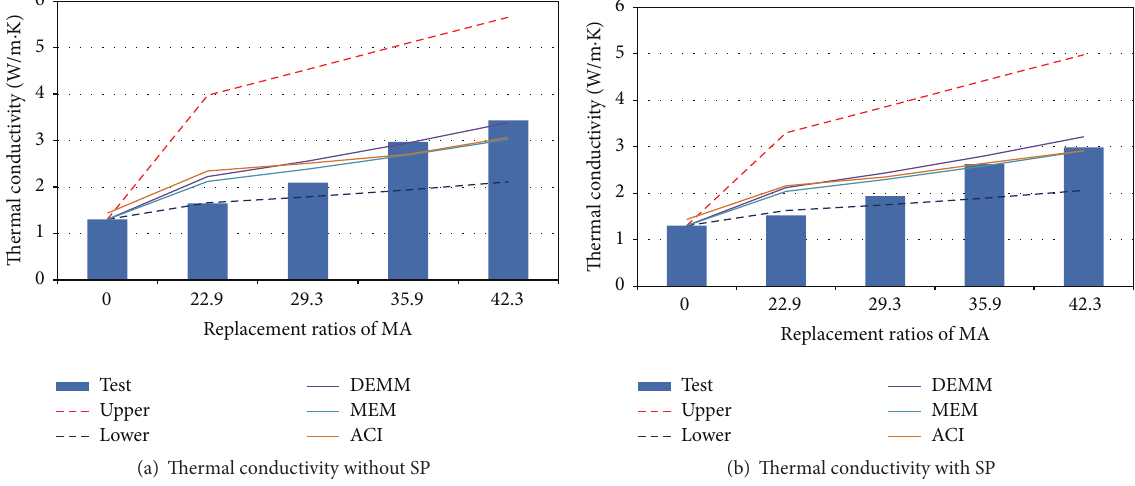
Figure 8: Thermal conductivity of test and several models.